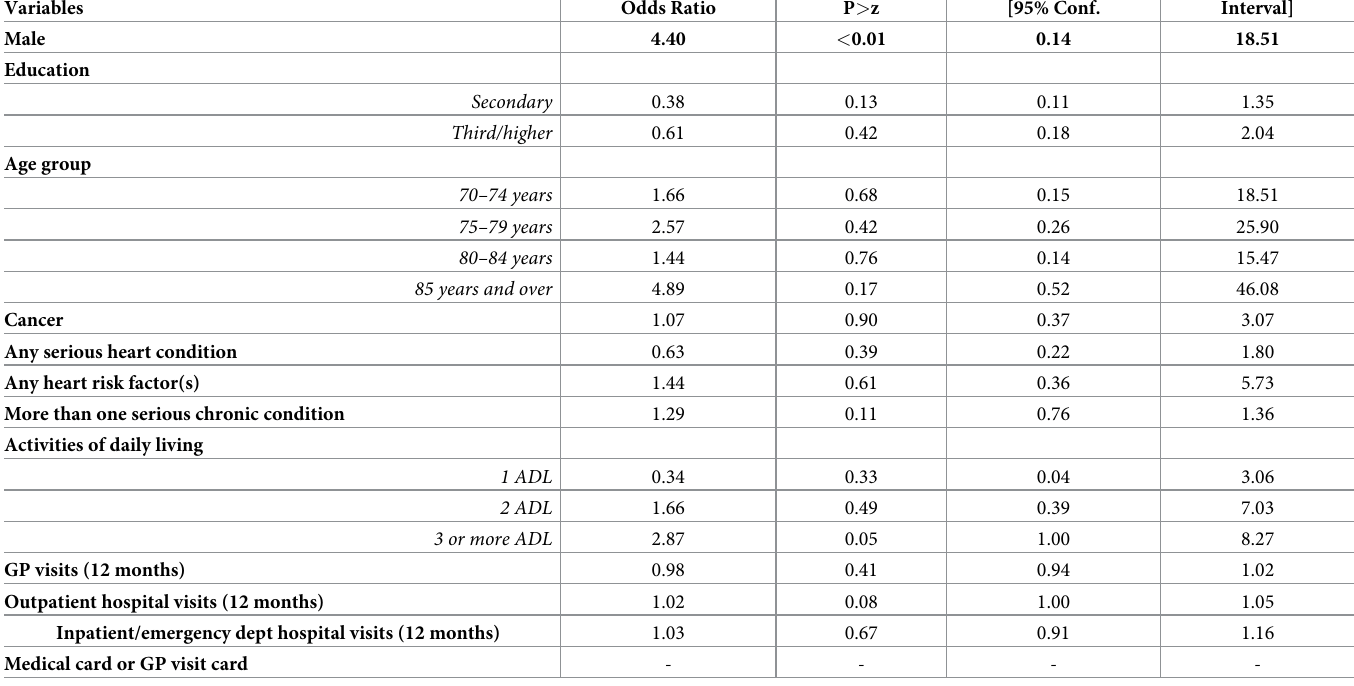
Regression results for potentially inadequate medications in LYOL are presented in Table 3, with statistically significant (p < 0.05) associations highlighted in bold. There is one such pre- dictor: male (OR 4.40, p = .004). Table 3. Multivariable regression results for potentially inadequate